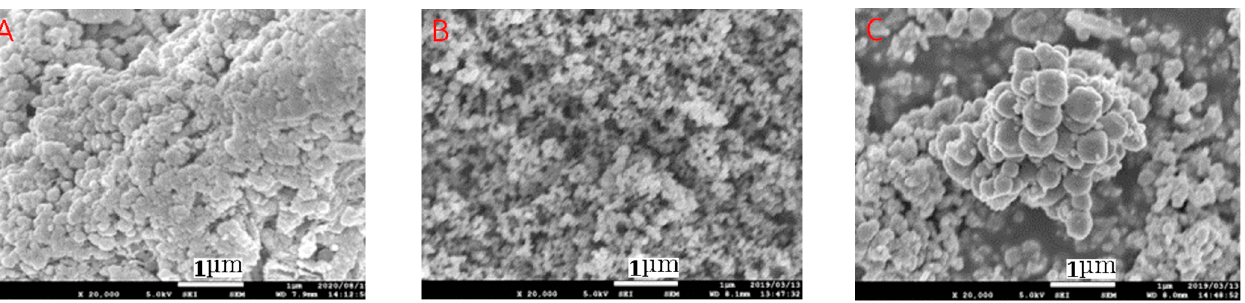
Figure 2. Scanning electron microscopy (SEM) images of the prepared conductive materials: ( A ) San-earth M5C, ( B ) Denka Black, and ( C ) Magnetite MTB-30.